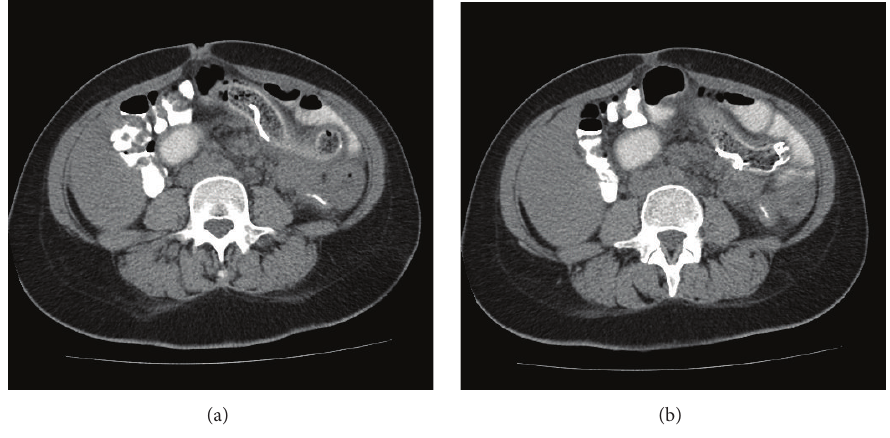
Figure 1: CT images revealing a calcified object inside bowel lumen.